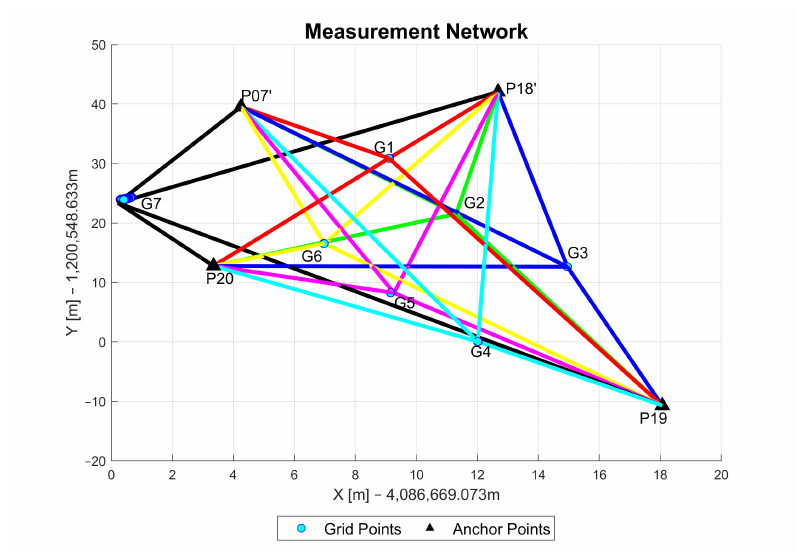
Figure 10. Sketch of the test site showing between which grid point and anchor point UWB range measurements were